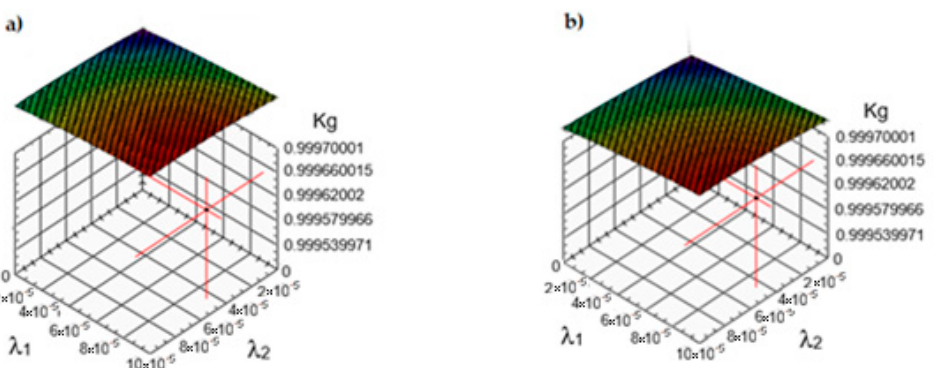
Figure 4. The Kg availability coefficient graphs show how the reliability of wind farm equipment is tested by varying the average repair time for constant parameters, such as type I mean service time = 0.8 (h), type II mean operating time = 1.3 (h), and mean time between successive failures = 1200 (h), where: ( a ) mean repair time = 0.3 (h) and ( b ) average repair time = 0.4 (h).